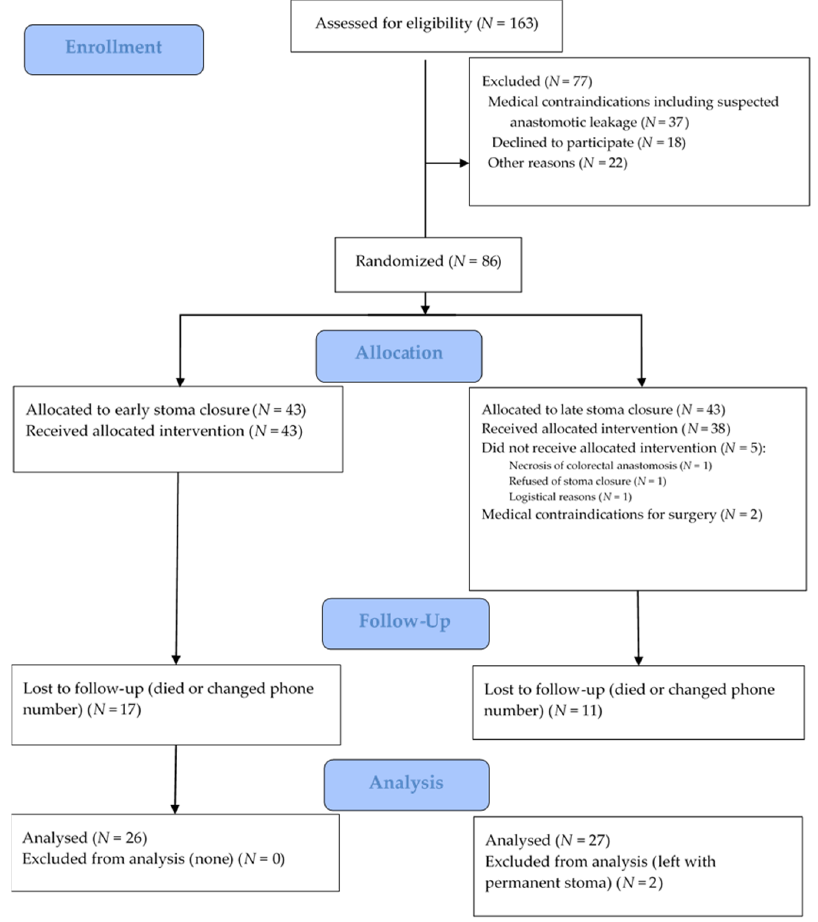
Figure 1. CONSORT flow diagram of patients included in the study. This study’s primary outcome was the comparison of quality of life and prevalence of LARS between the